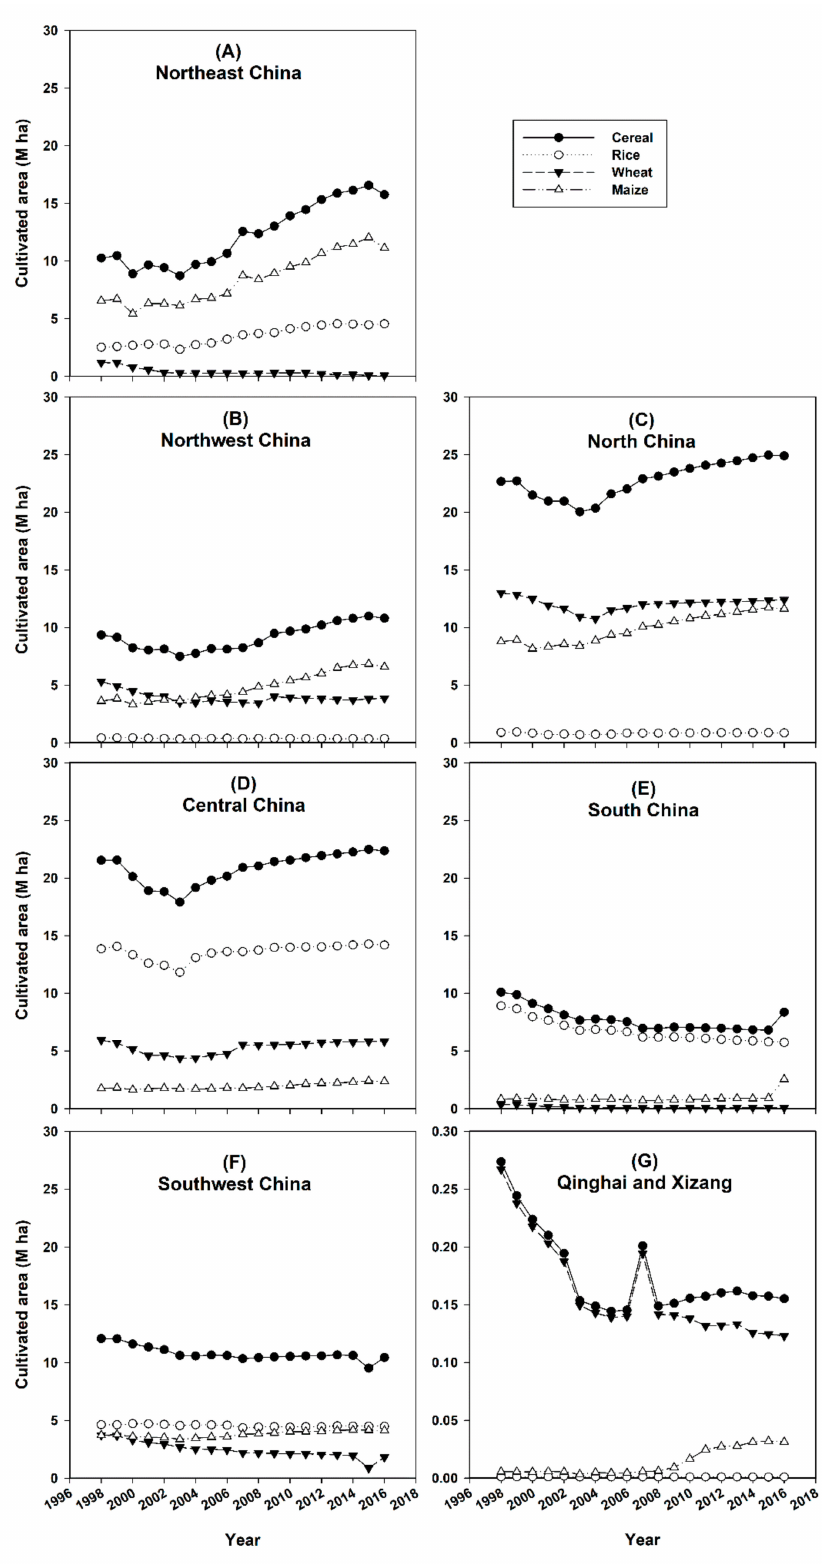
Figure 5. The spatial variation in the cereal, rice, wheat, and maize cultivated area (M ha) in northeast China ( A ), northwest China ( B ), north China ( C ), central China ( D ), south China ( E ), southwest China ( F ), and Qinghai and Xizang ( G ) from 1998 to